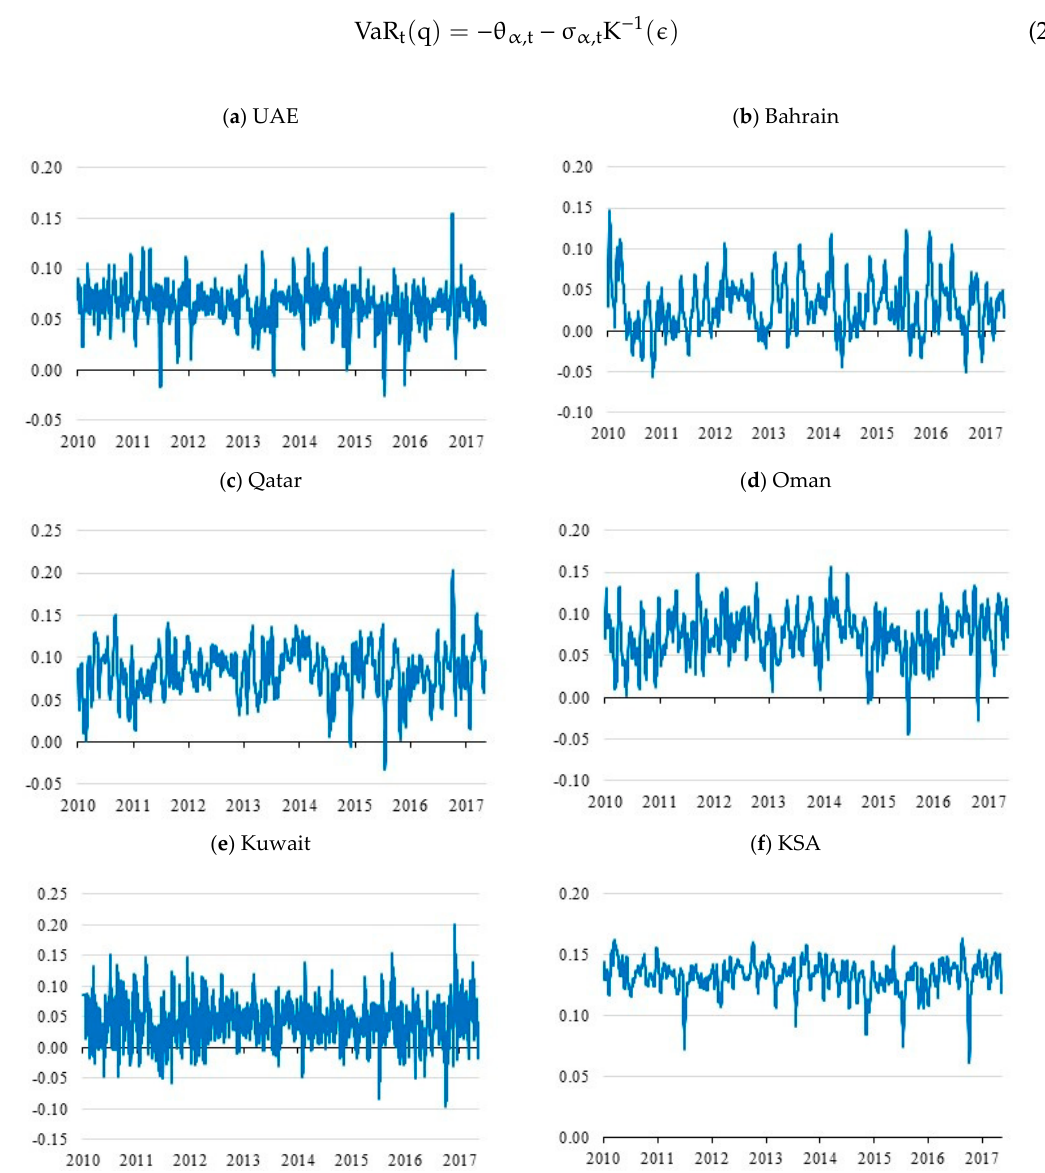
Figure 3. Time-varying correlations of GCC with S&P 500 for the student-t copula: ( a ) UAE; ( b ) Bahrain; ( c ) Qatar; ( d ) Oman; ( e ) Kuwait; ( f ) KSA.